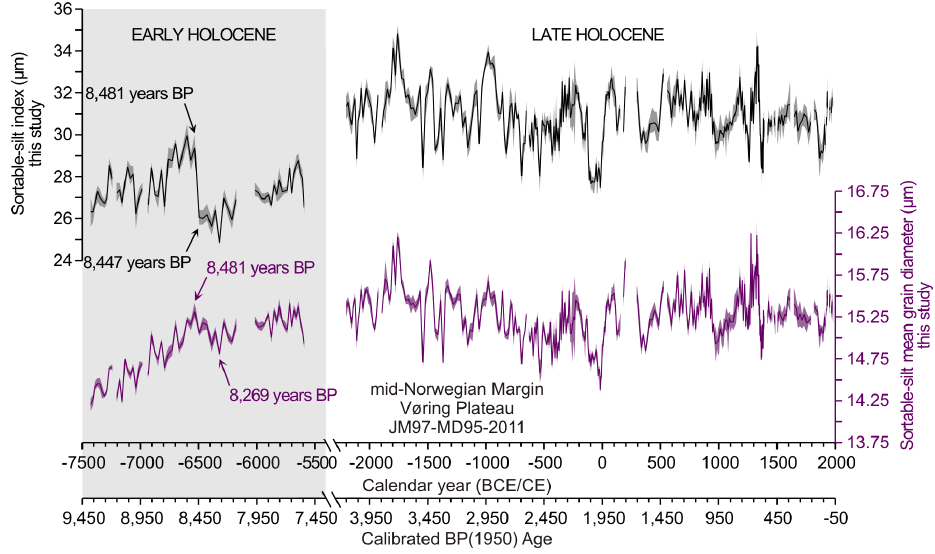
Figure 3. The two alternative sortable-silt time series from JM97-MD95-2011 (Vøring Plateau, mid-Norwegian Margin). Note the 4-fold difference in scale between the records. The shaded envelopes indicate the spread of values resulting from repeated measurements. The mean ± 1 σ error in the age model is ± 128 years over the late Holocene and ± 201 years over the early Holocene.